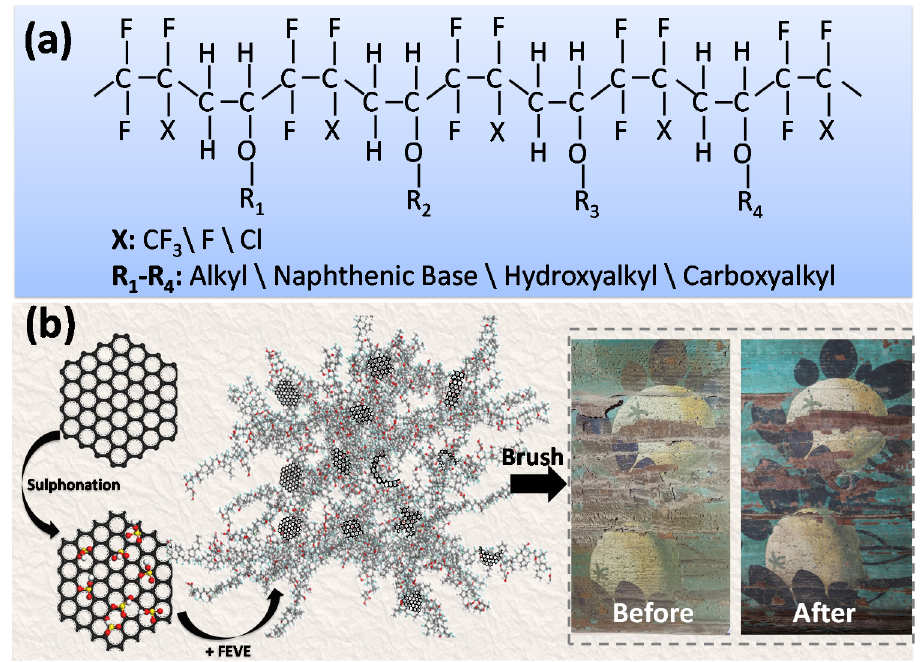
Figure 2. ( a ) Molecular formula of FEVE. ( b ) Diagram of the synthesis of FEVE/m-GO and Sanyou Xuan color painting application.